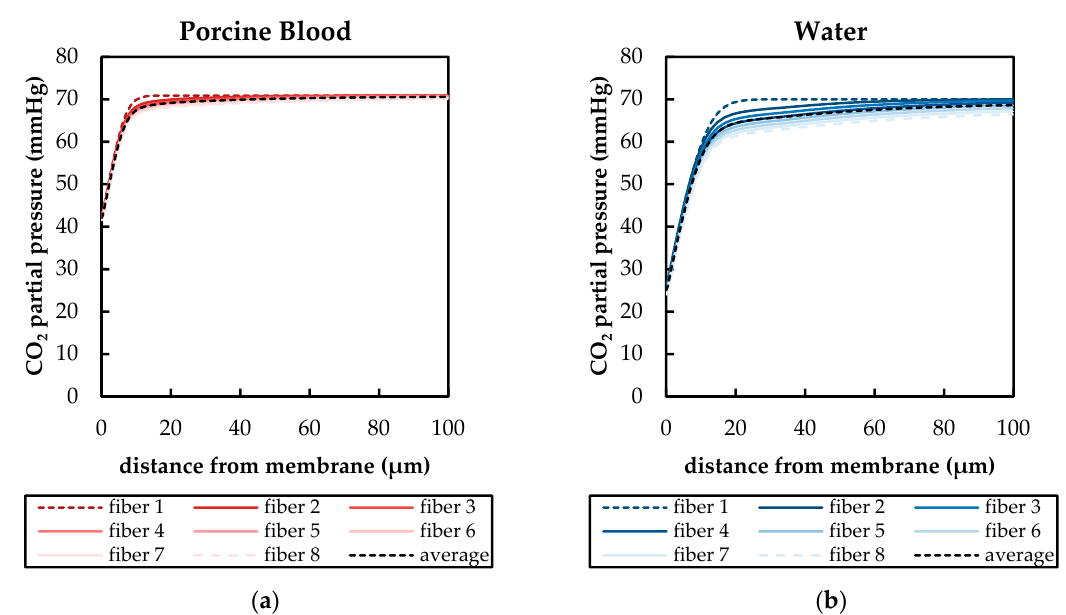
Figure 14. CFD boundary profiles of CO 2 partial pressure at different fiber positions (sampling line illustrated in Figure 7a) for an inlet p CO2 of 70 mmHg and inlet velocity of 0.02 m/s (approx. 1300 mL/min), fiber 1—first fiber at inlet, fiber 8—last fiber at outlet: ( a ) porcine blood, ( b ) water.